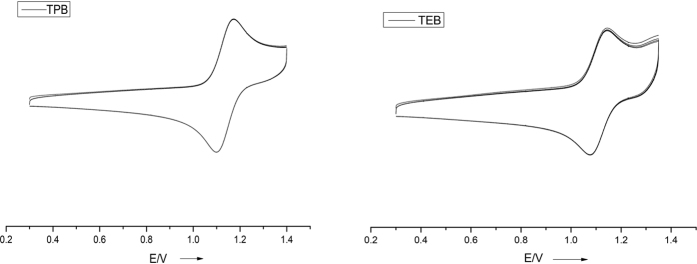
Cyclic voltammograms of TPB and TEB in CH2Cl2 (2 × 10−4 M, 0.1 M n-NBu4PF6) were measured at 50 mV/s at 288 K.(ETEBox = 1.17 V, ETPBox = 1.18 V, vs Ag/Ag+; working electrode: platinum, reference electrode: Ag/AgCl, and counter electrode: platinum wire; Scanning direction is from negative to positive).